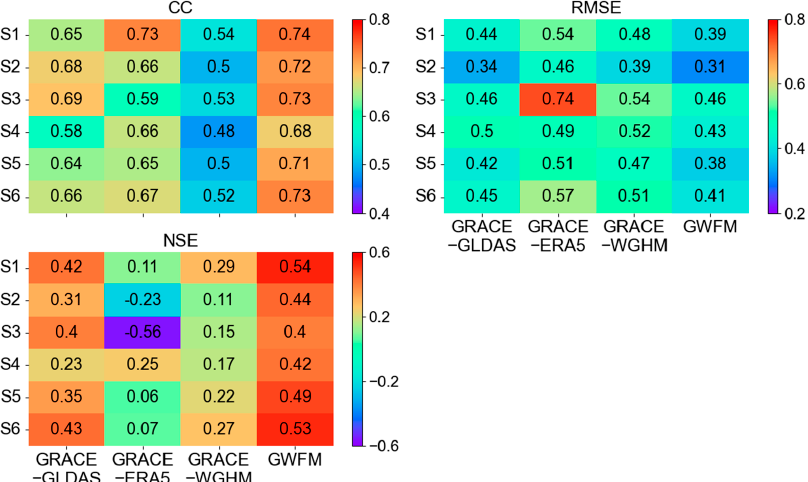
Figure 5. Comparison of the evaluation index between GWSA and in situ groundwater-level measurements.